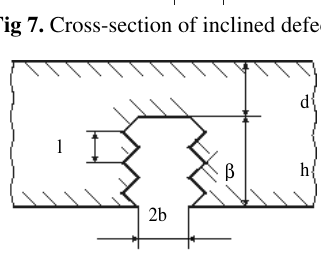
Fig 7. Cross-section of inclined defect